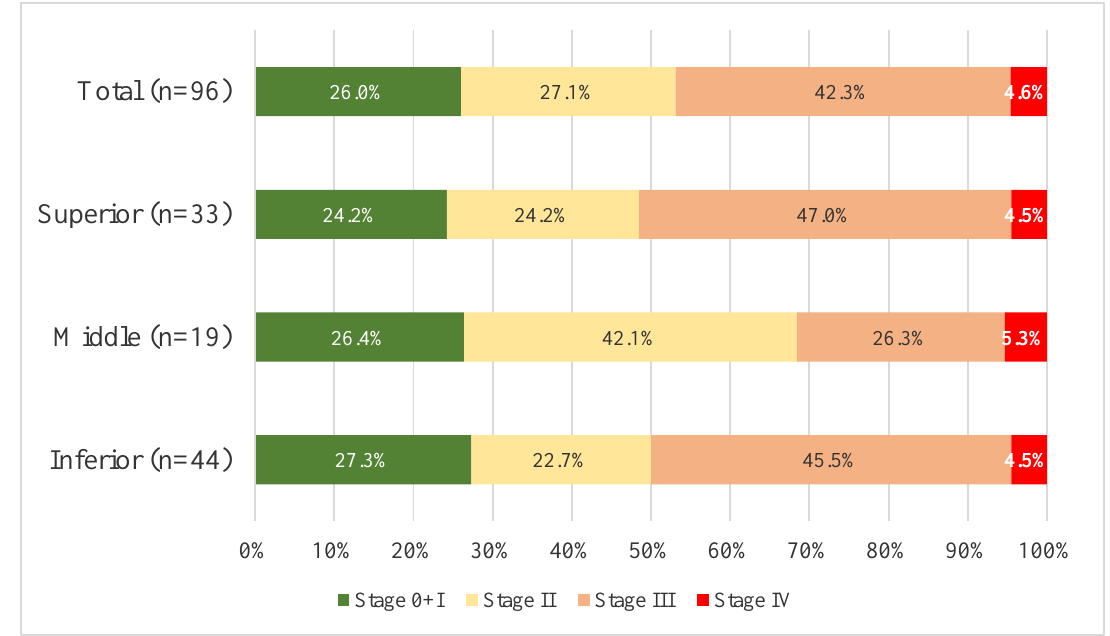
Figure 2. The structure of patients with complications by tumour position and pTNM stage.